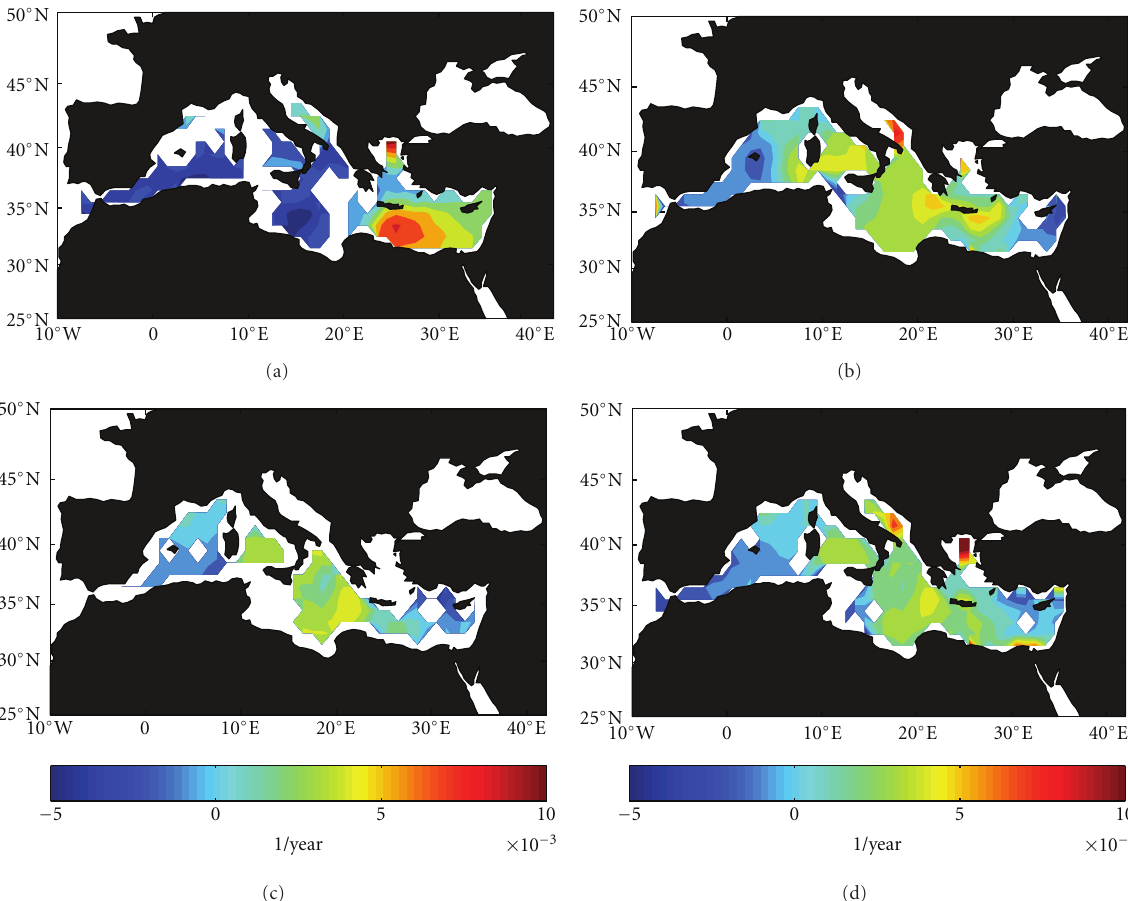
Figure 4: Spatial distribution of the salinity trend from the ECCO model data (93–09) for the di ff erent layers: (a) surface layer (0–150 m), (b) intermediate later (150–600 m), (c) deep layer (600 m–bottom), and (d) entire water